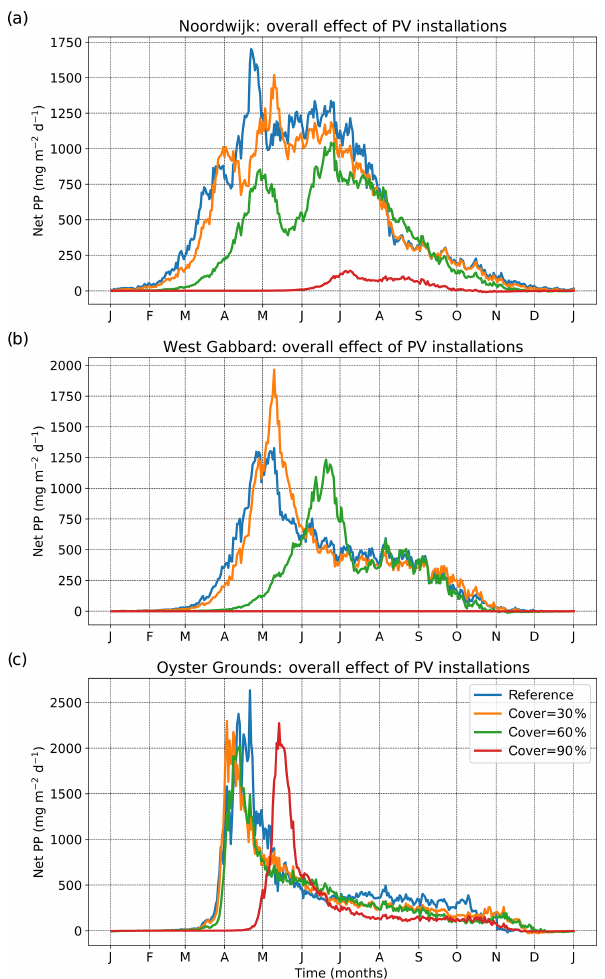
Figure 4. Depth-integrated yearly time series (averaged over 1998– 2008) of net primary production for the three locations of the exper- iment. The results are presented for different scenarios of coverage under the overall effect of floating platforms.